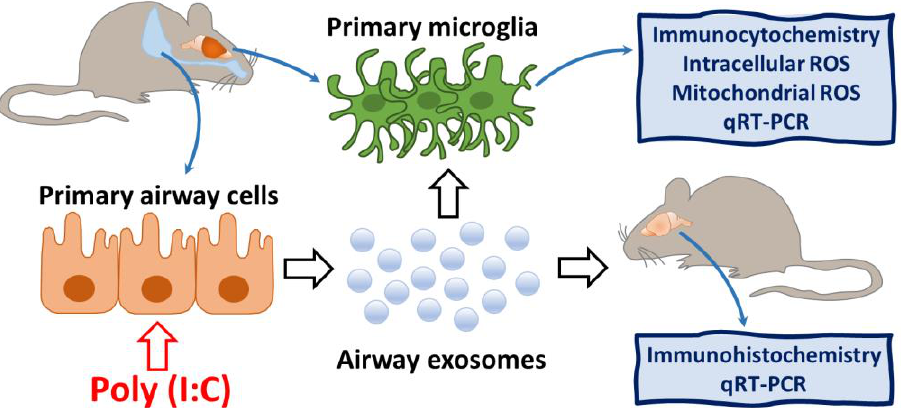
Figure 1. The experimental design of the study. Primary airway cells of rodent origin were treated with poly (I:C), and their ELVs were applied on microglial cell cultures and intranasally to mice. Microglial cells in vitro and in vivo were investigated for particle internalisation, and cultured microglia were analysed for intracellular and intramitochondrial ROS production.